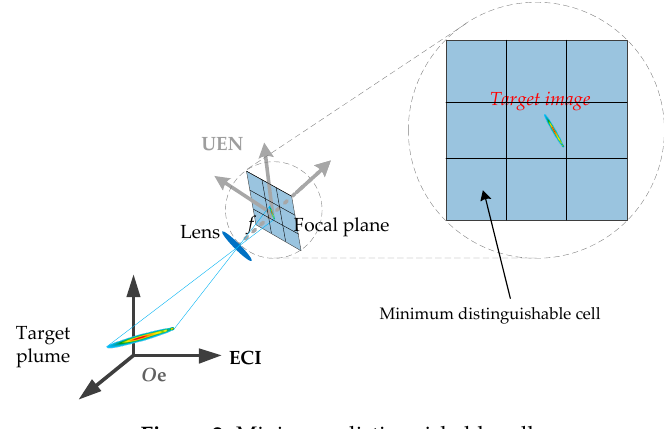
Figure 2. Minimum distinguishable cell.